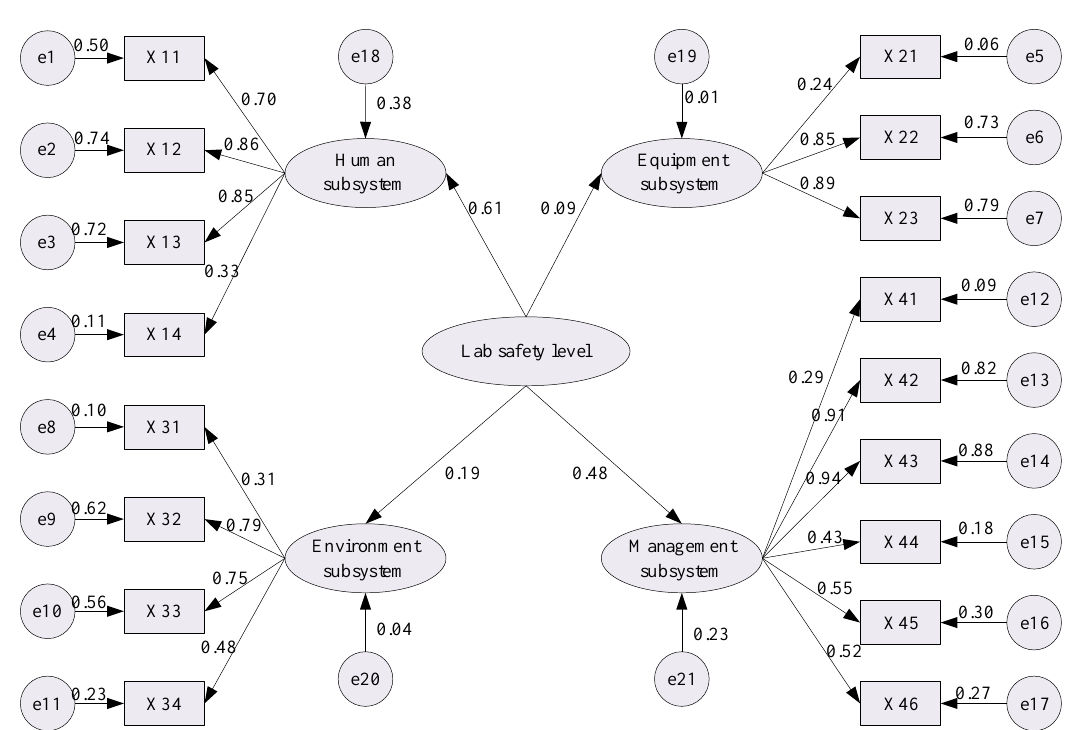
Figure 3. Standardized estimation results of Initial SEM. Table 6. Initial SEM fit results.